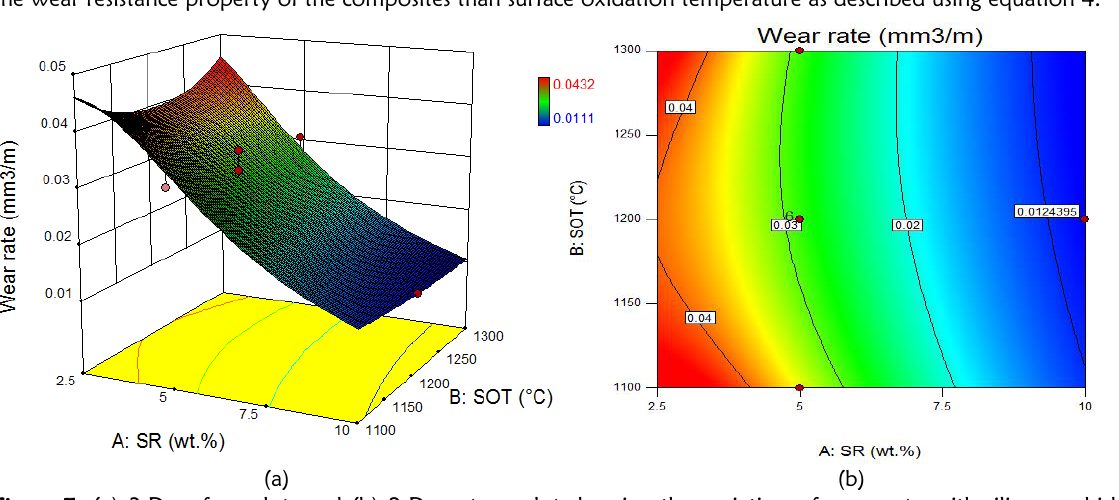
Figure 7: (a) 3-D surface plot, and (b) 2-D contour plot showing the variation of wear rate with silicon carbide reinforcement fraction and surface oxidation temperature